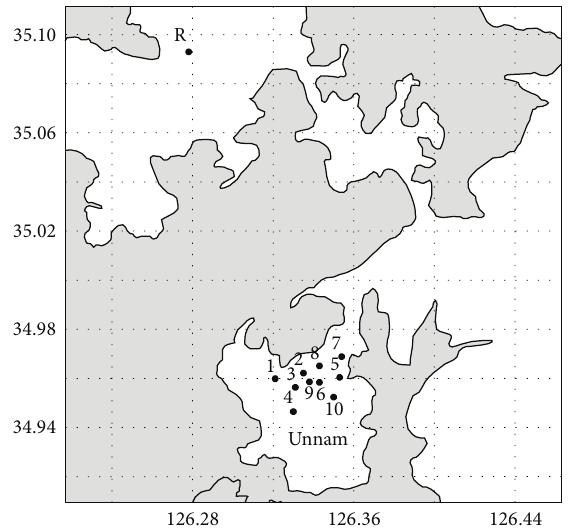
Figure 3: Layout of NIMS-XPOL and the 10 rain gauges near Unnam-myeon, Muan-gun, Jeollanam-do, Korea. R shows the location of the NIMS-XPOL; the numbered points indicate the observational sites of the 10 rain gauges.